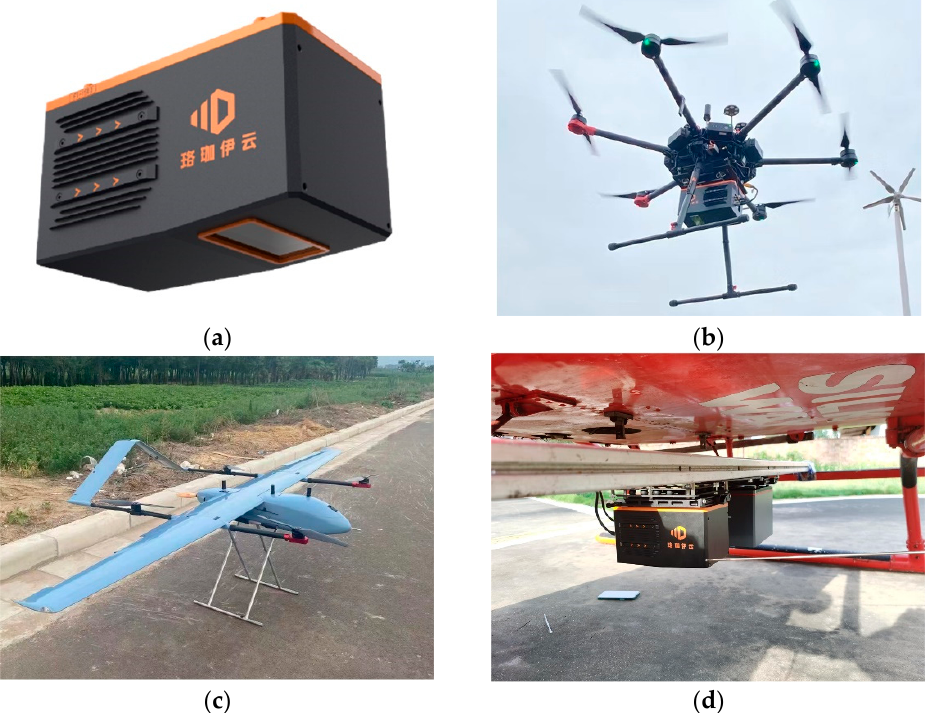
Figure 1. Equipment and platform. ( a ) Luojia Yiyun FT1500; ( b ) multi-rotor UAV; ( c ) fixed-wing UAV; ( d ) manned helicopter. The text in the image is the Chinese name (Luojia Yiyun) for LiDAR. The ranging module and scanning module of the system will be introduced below.